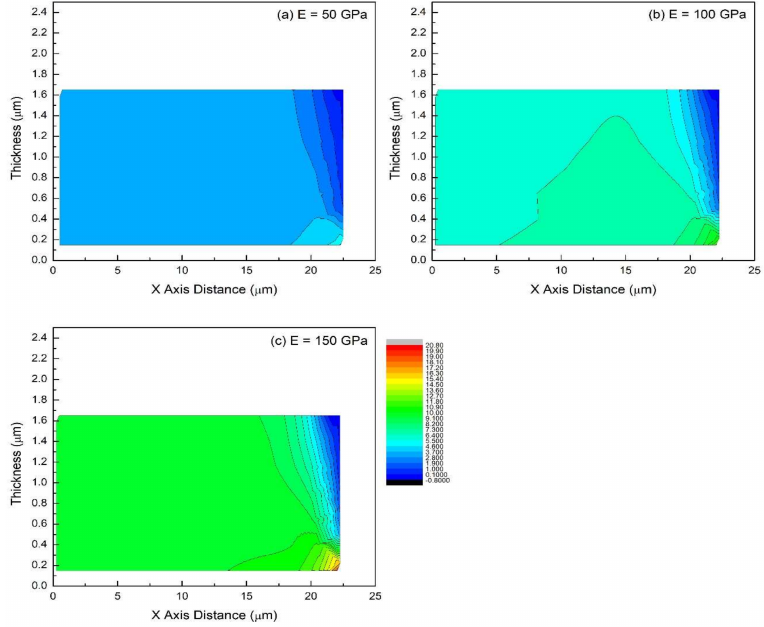
Figure 7. The in-plane stress distribution (2D-contour plot) in films of different Young’s modulus for the case of the film/substrate system being tested in tension: ( a ) E = 50 GPa, ( b ) E = 100 GPa, ( c ) E = 150 GPa. Common features: E SS = 200 GPa, δ = 1.8 µ m, λ max = 45 µ m, ε f =